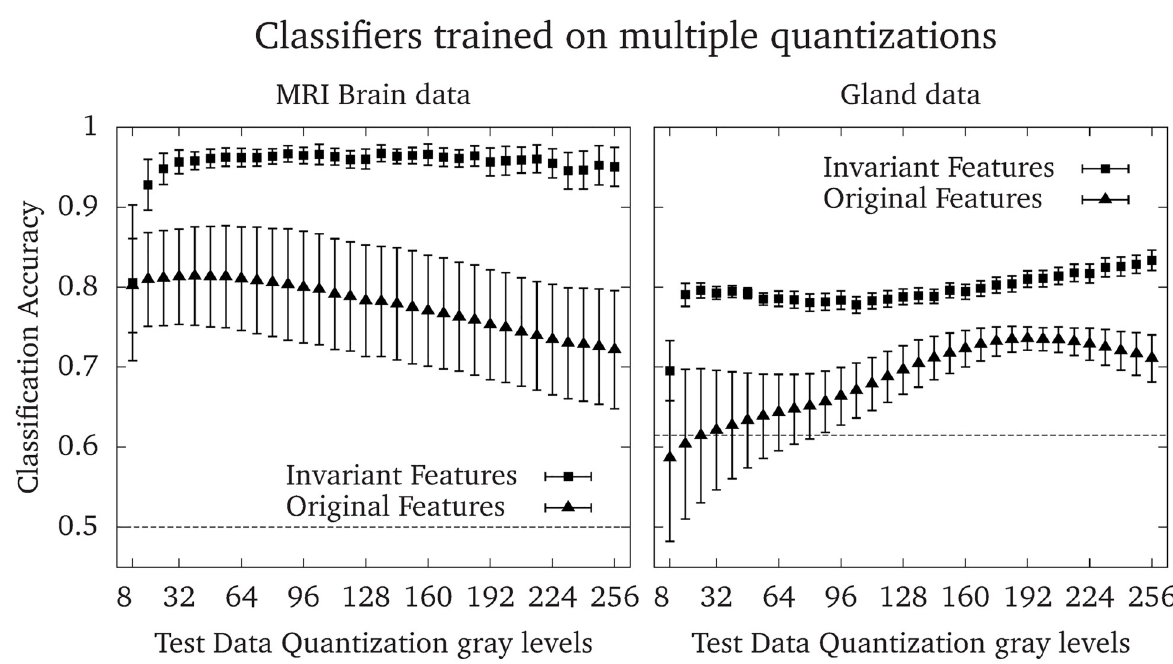
Fig 6. Accuracy of classifiers trained on multiple quantization gray-levels. To evaluate the performance of classifiers that were trained on a wide range of quantizations, 100 logistic regression models were trained for each data set and method. Each image in the training data was randomly quantized to one of 32 quantization gray-levels between 8 and 256 for every model. The markers show the mean accuracy and the error bars show the standard deviations of the accuracy for each quantization of the test data. The dashed line shows the accuracy obtained by assigning all predictions to the most common class, which is 0.5 for either the cerebellum or prefrontal cortex in Dataset 1 and 0.615 for benign glandular structures in Dataset 2.